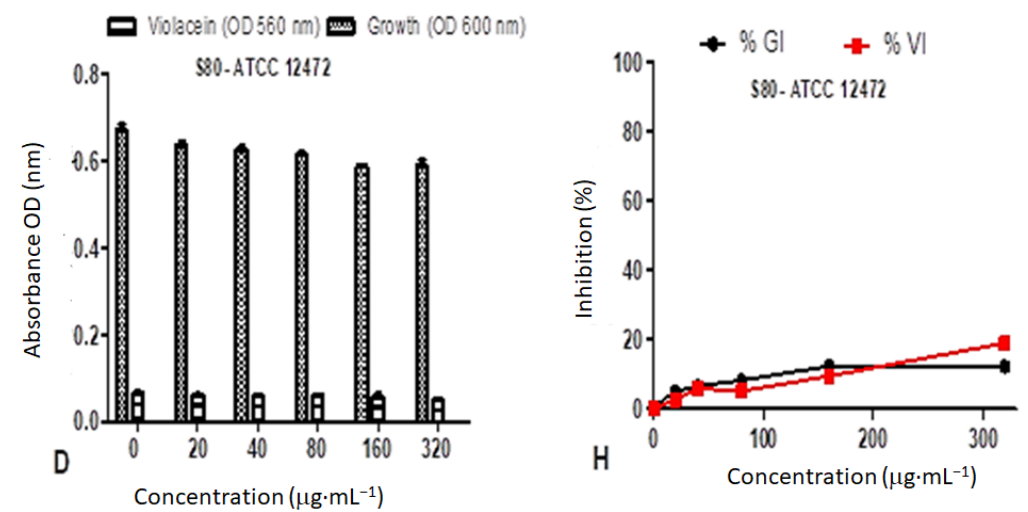
Figure 12. Quantitative analysis of the inhibitory effect of different concentrations of D. villosa leavesAgNPs synthesized at both room temperature (RT) and at 80 ◦ C (80) on production of violacein by Chromobacterium violaceum ATCC 12472. Cultures were grown in the presence of 0–320 µ g/mL of respective leaves nanoparticles at RT and 80 ◦ C. Frames ( A – D ) represent growth (OD 600 nm) and violacein inhibition (OD 560 nm) following nanoparticle treatment, while frames ( E – H ) represent %growth (%GI) and % violacein (%VI) inhibition. Data represent the average of triplicate independent experiments and SD.